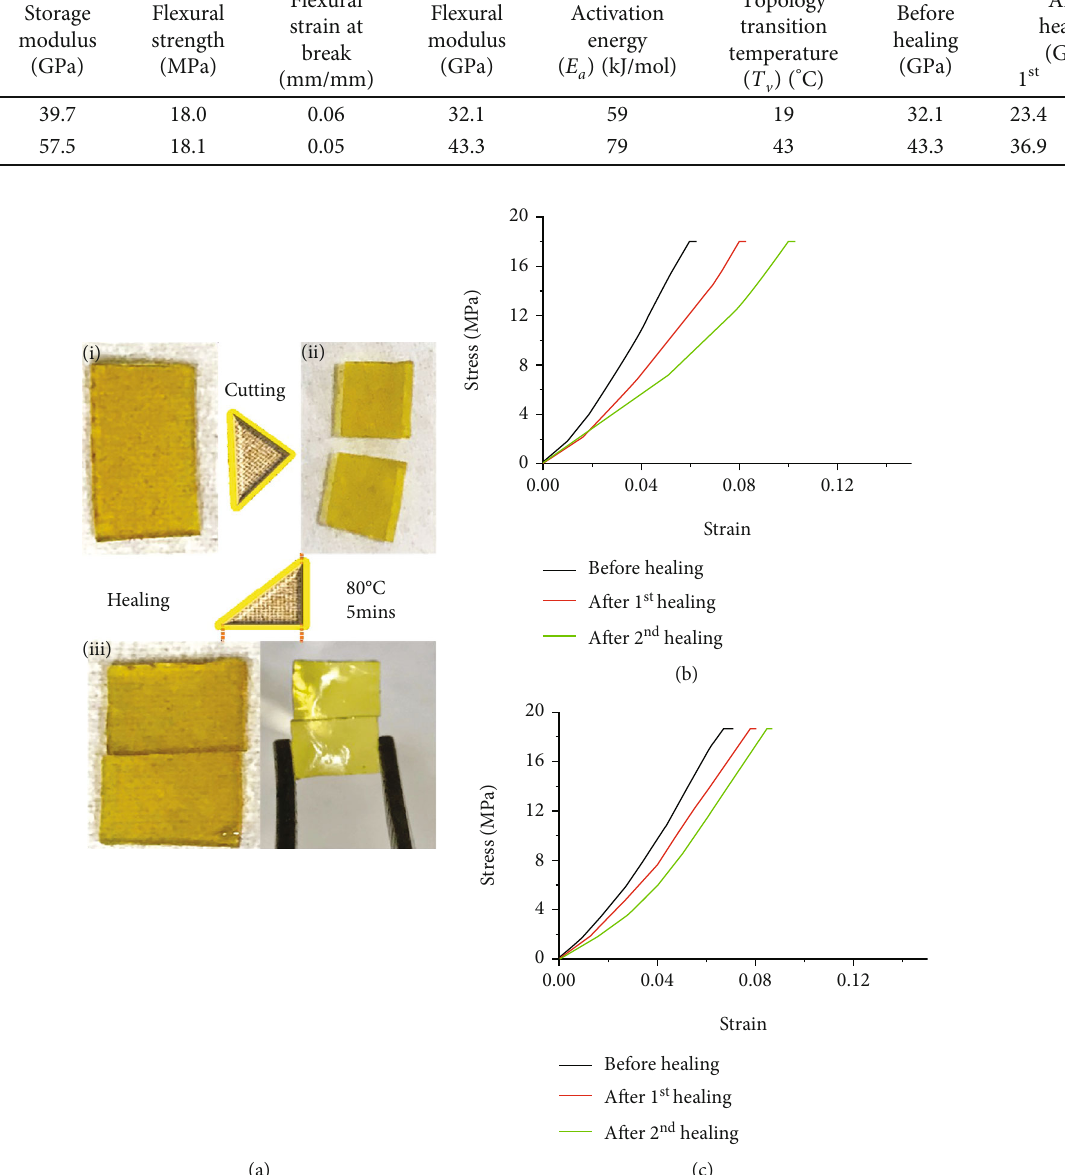
Table 2: Dynamic properties of epoxy for epoxy and biocomposite vitrimers.